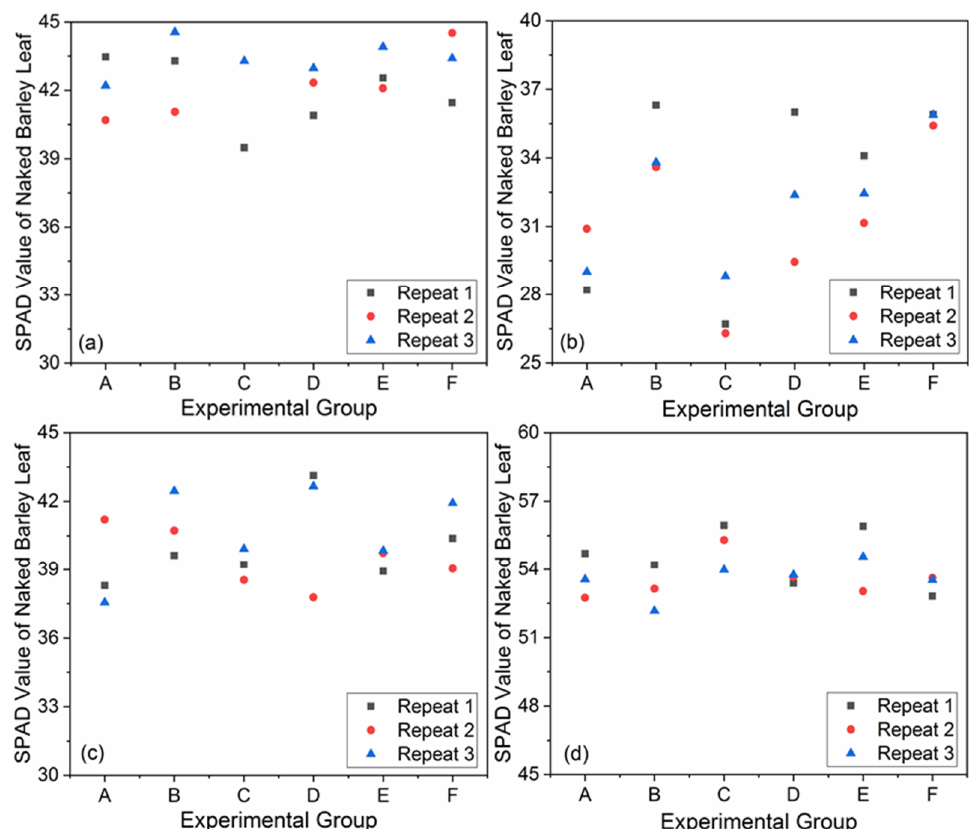
Figure 5. Measured soil and plant analysis development (SPAD) values of each experimental group on 8 December 2018 ( a ); 8 January 2019 ( b ); 5 February 2019 ( c ) and 14 March 2019 ( d ). Table 3. The result of one-way analysis of variance of SPAD values for different fertilizer treatments and growth stages at 0.05 probability level. F-Value p -Value Different fertilizer treatments